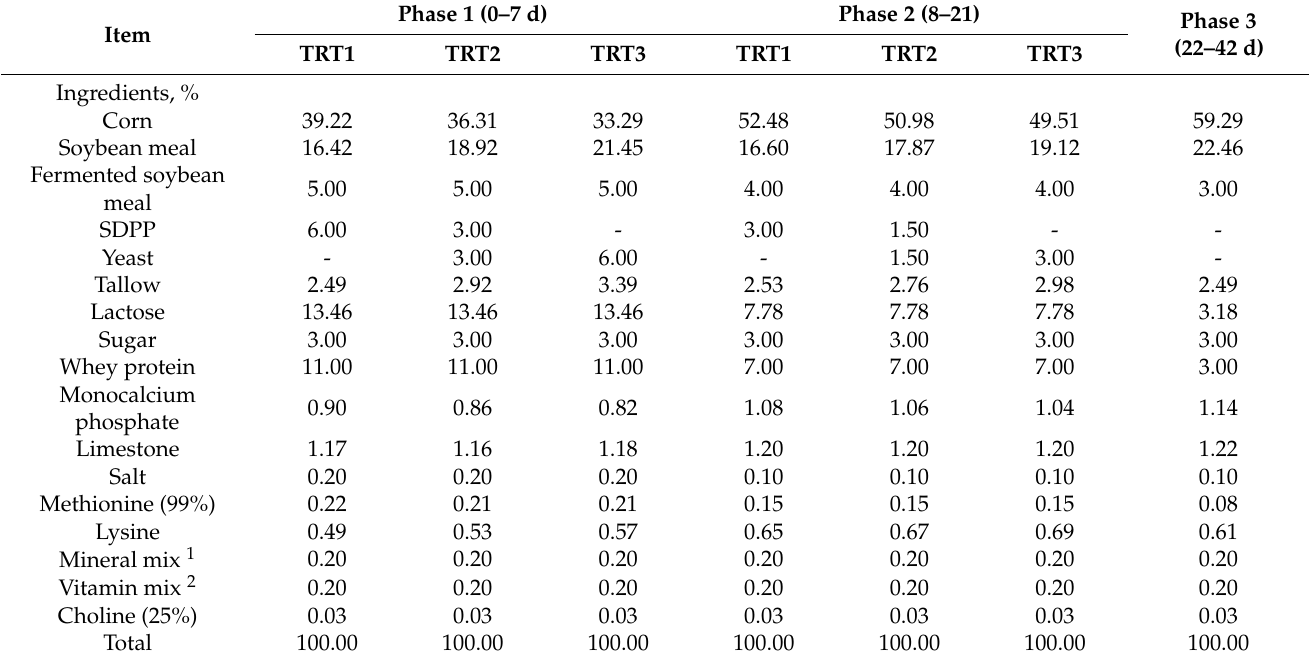
Table 1. Composition of weaning pig diets (as